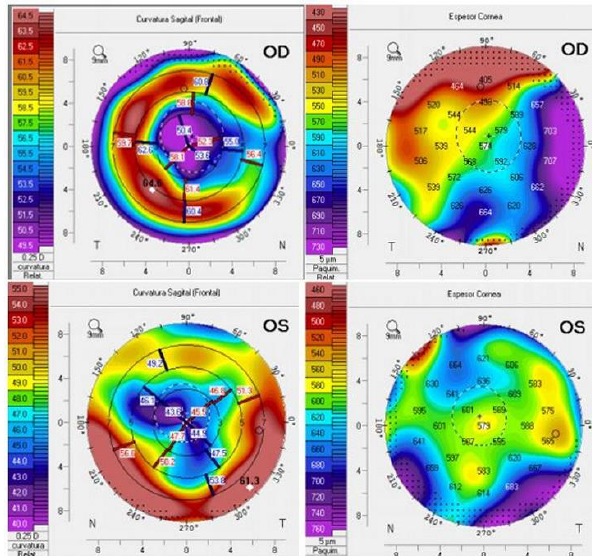
Figure 3 : Corneal topography on our last follow-up, year 8 after the diagnosis, showing maximum keratometry value on OD of 64.6D (a), and minimal corneal thickness of 444μm (b). On OS maximum keratometry value is 61.3D (c) and minimal corneal thickness of